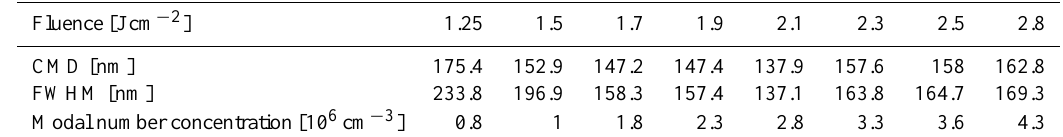
Table 1. Various parameters of the fractal aggregate mode as a function of the laser fluence in case of nitrogen carrier gas with a volumetric flow rate of 500cm 3 min − 1 .